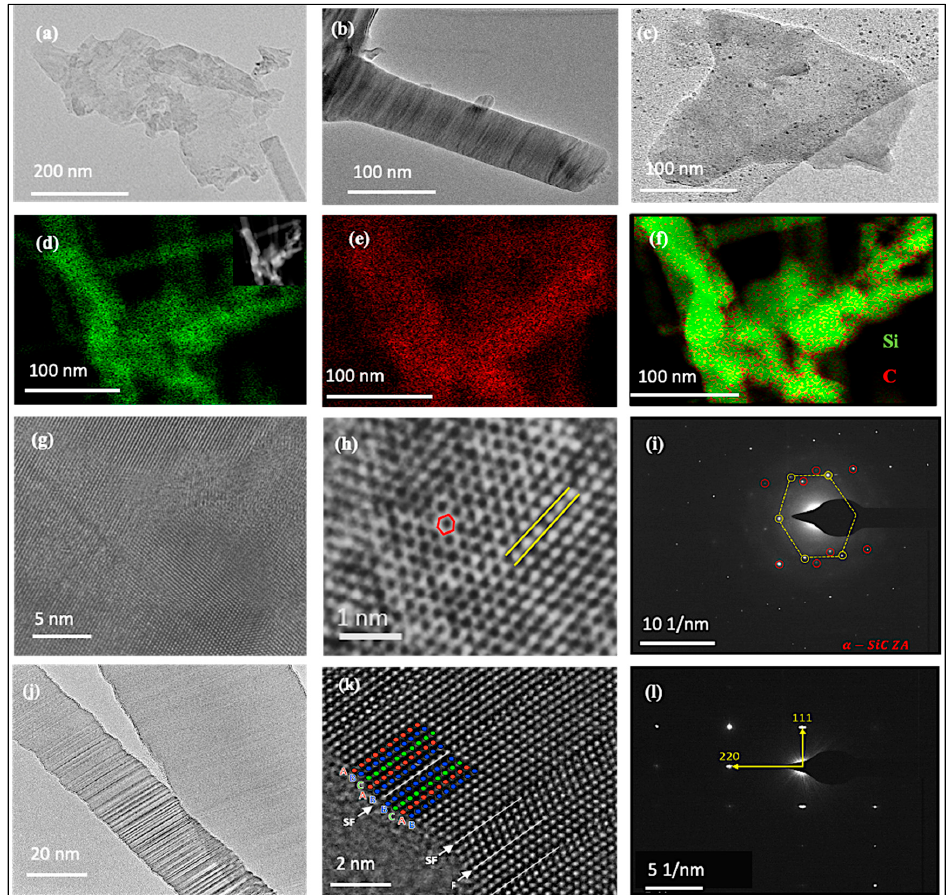
Figure 3. TEM results: ( a – c ) TEM images revealing that the grown 3D structures were composed of nanosheets and nanowires; ( d – f ) elemental X-ray mappings corresponding to the STEM-HAADF images shown in the inset of image ( d ); ( g ) HRTEM image showing the highly crystalline nature of the grown material; ( h , i ) HRTEM images of a different structure and the associated selected area electron diffraction pattern; ( j , k ) HRTEM images of a grown twinned nanowire (left) and ( l ) its indexed selected area electron diffraction pattern.